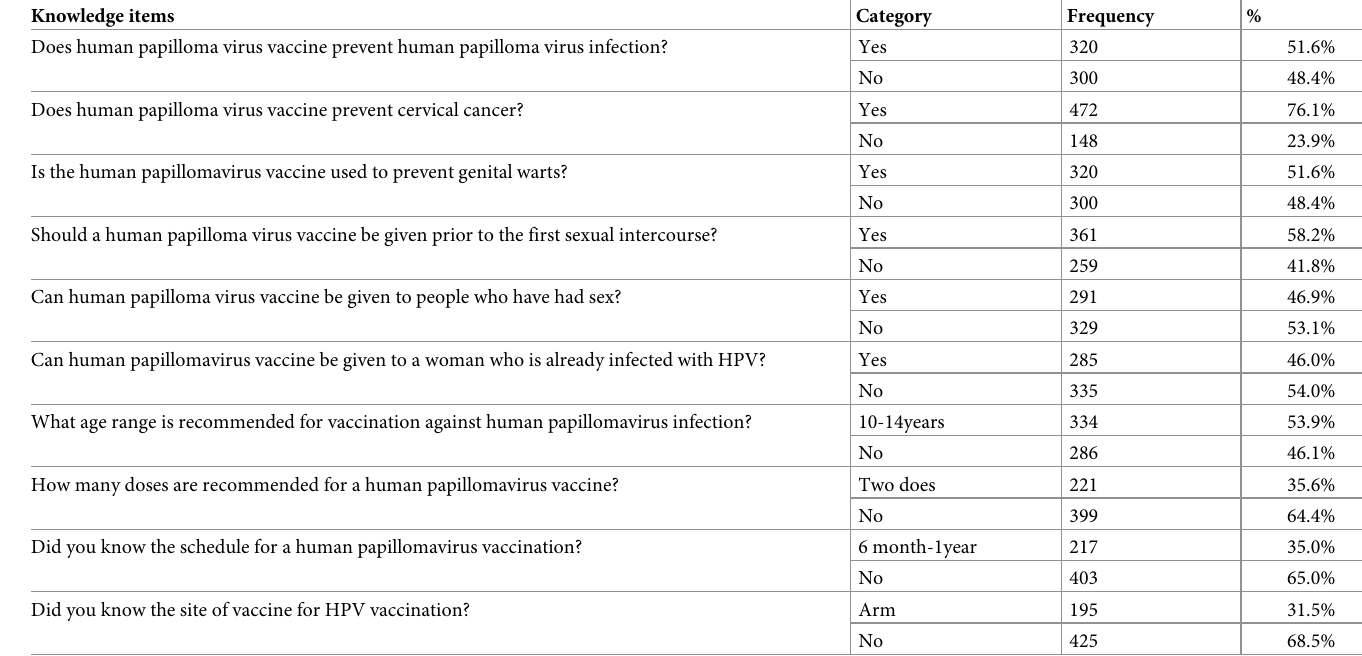
Table 2. Knowledge toward HPV vaccination among female preparatory school students, Bahir Dar, Ethiopia, 2021(n = 620). Knowledge items